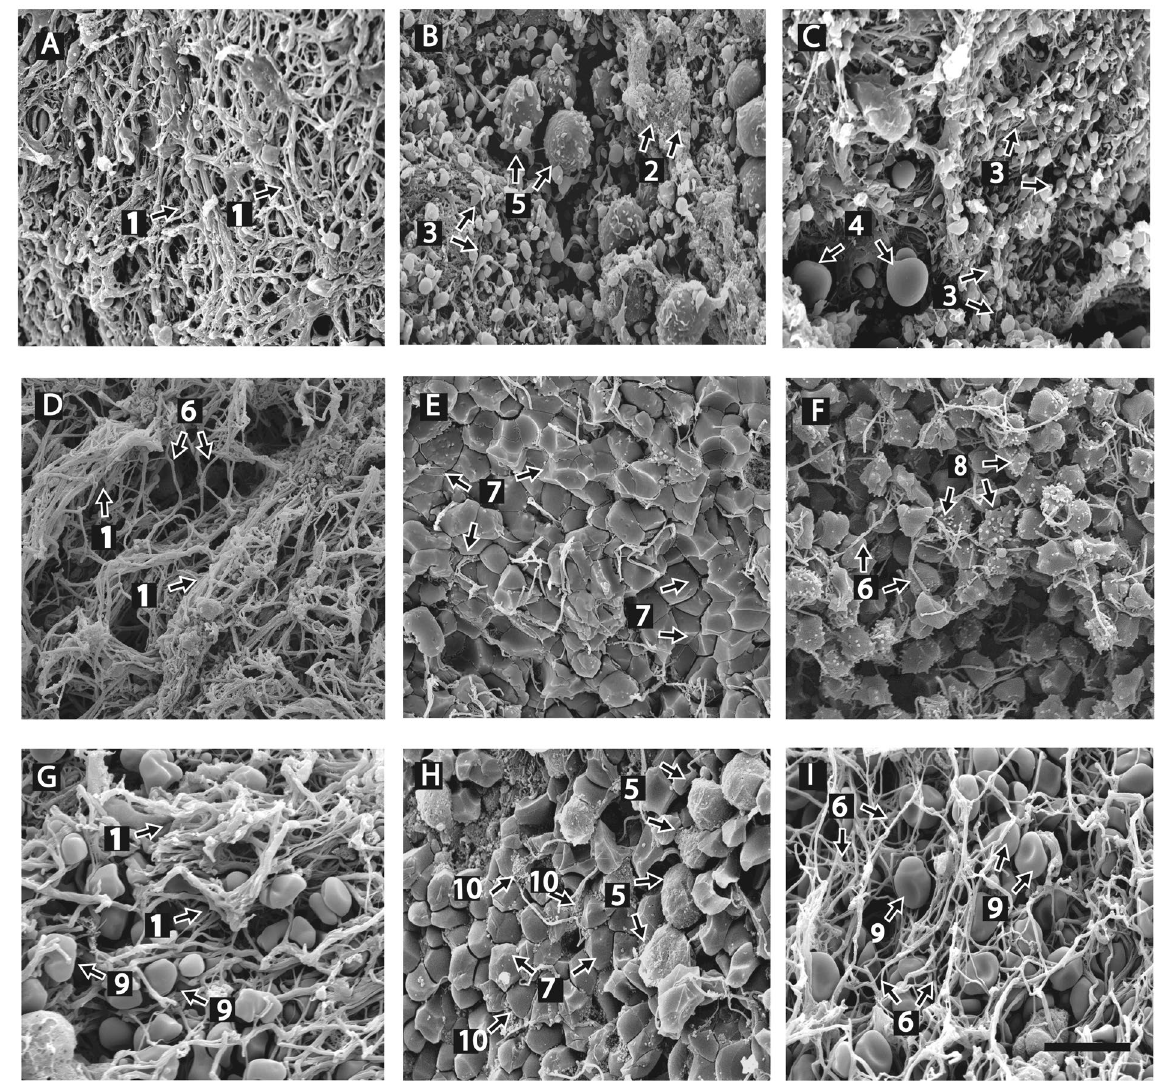
Figure 1. Representative scanning electron microscope images of thrombi and emboli. Structures identified in arterial and venous thrombi and pulmonary emboli. Panels A–C are images of arterial thrombi. Panels D–F are images of venous thrombi. Panels G–I are images of pulmonary emboli. ( A ) Arterial thrombus: fibrin structure is primarily composed of fiber bundles (1) and ( B ) fibrin sponge (2). ( B , C ) Dense contracted thrombi with platelet aggregates (3) with fibrin on the outside and red blood cell balloons (4) trapped in the fibrin mesh; some white blood cells were also present (5). ( D ) Venous thrombus, mostly fibrin structure is primarily composed of fiber bundles (1) and individual fibrin fibers (6). ( E ) Tightly packed RBCs in the form of polyhedrocytes (7) with a few fibrin fibers. ( F ) Fibrin fibers (6); RBCs present as polyhedrocytes and echinocytes (8). ( G ) Pulmonary embolus, bundles of fibrin (1) with intermediate forms of RBCs trapped inside (9). ( H ) Mostly polyhedrocytes (7) and extracellular microvesicles (10) as well as many white blood cells are present (5). ( I ) Individual fibrin fibers (6) and intermediate forms of RBCs (9). Magnification bar = 10 µ